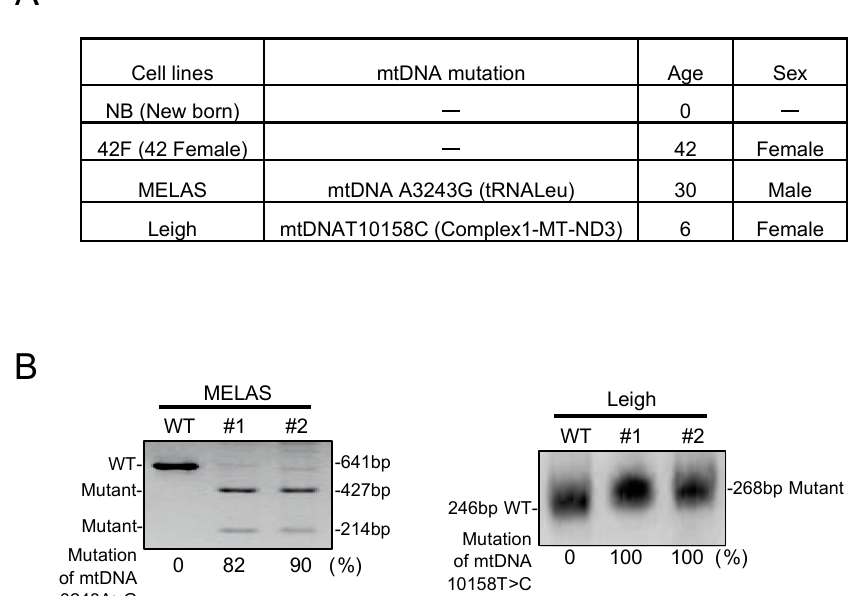
Figure 1. Isolation and characterization of fibroblasts from mitochondrial disease patients. ( A ) Overview of cell lines used in this study. ( B ) Heteroplasmy rate measured by restriction fragment length polymorphism (RFLP). The 3243A > G mutation was digested by Apa1, while the 10158T > C mutation was not digested by Taq1. MELAS: Mitochondrial myopathy, encephalopathy, lactic acidosis, and stroke-like episodes.